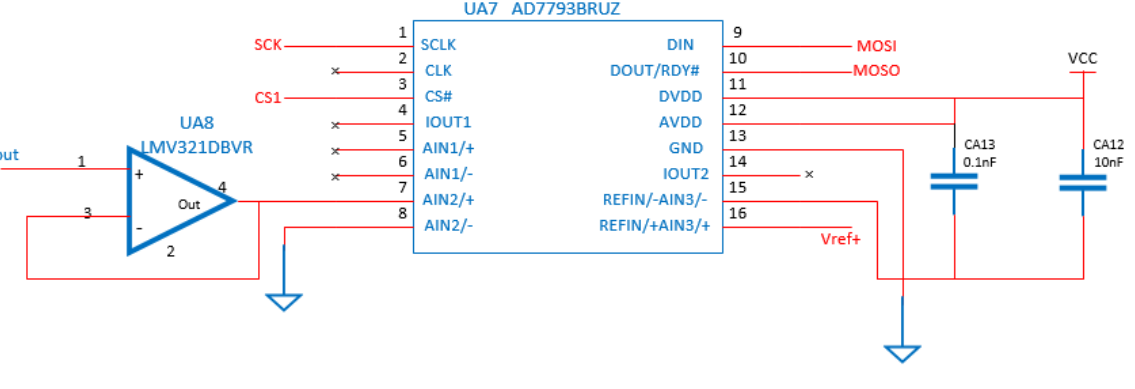
Figure 7. Signal acquisition circuit.